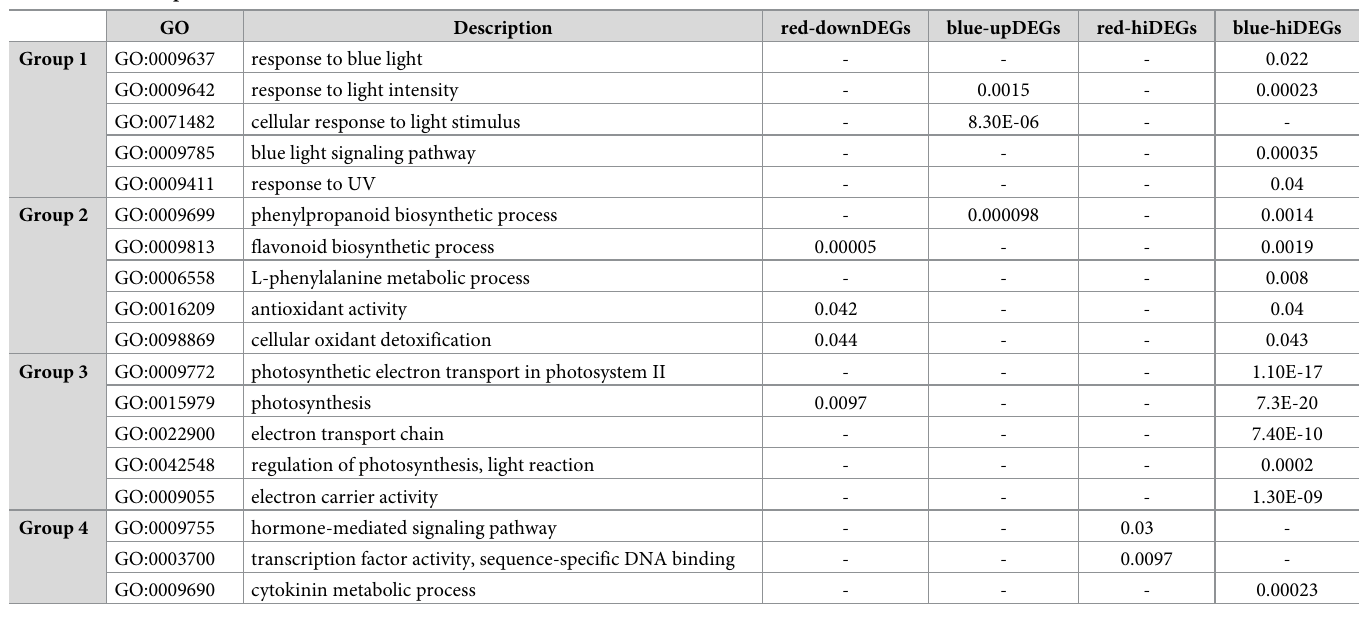
The p-values of the GO enrichment analysis in each of red-downDEG, blue-upDEG, red-hiDEG, and blue-hiDEG sets are shown. The lower p-value represent a higher significance of the enrichment of that GO term. Dash symbol shows the insignificance of a GO